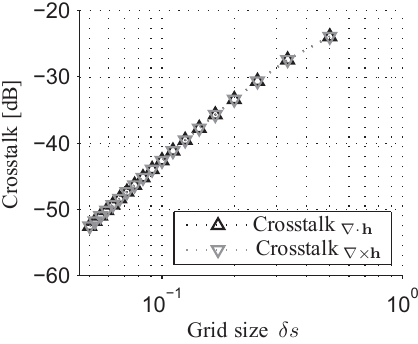
Figure 3. Resulting crosstalk, according to Eq. (13) as a quality factor of the natural Helmholtz–Hodge decomposition, when ap- plied to the synthetic input vector field from Eq. (11) for several grid sizes δs of the vector